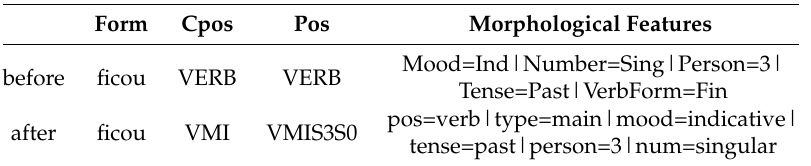
Table 2. Sample of tag